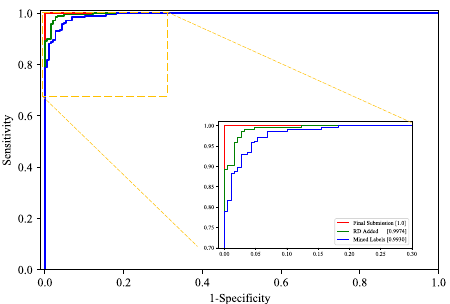
Figure 4. ROC curves on the labeled competition dataset. The initial model was trained with mined labels. The second model was fined-tuned from the initial model by adding cases for retinal detachment to training data. The final model was improved from the second model by adding the labeled competition dataset to training data. The final model achieved the best AUROC of 0.9993 on the offsite validation set. AUROC is shown in